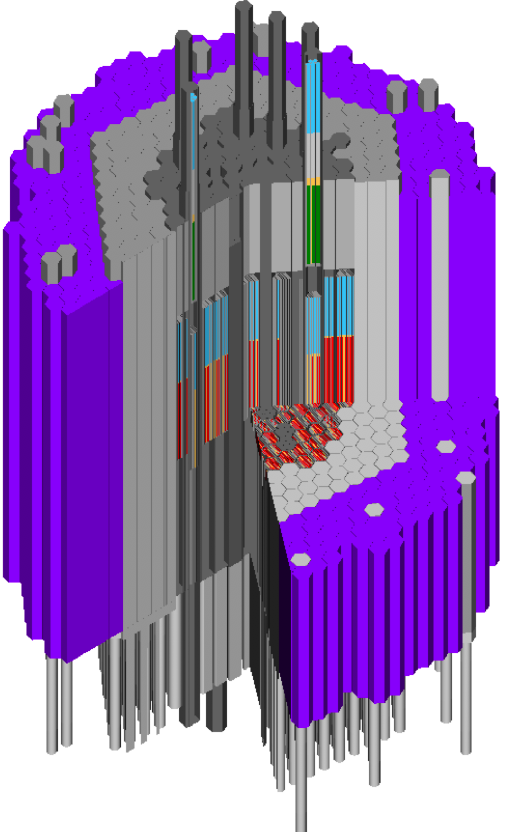
Figure 4. SCALE full core model of the EBR-II. The inner driver core region (driver fuel in red, bond sodium in yellow, gas plenum in blue) is surrounded by a steel reflector (gray), which is surrounded by the blanket assemblies (purple). The green region shows absorber material in one of the control assemblies.